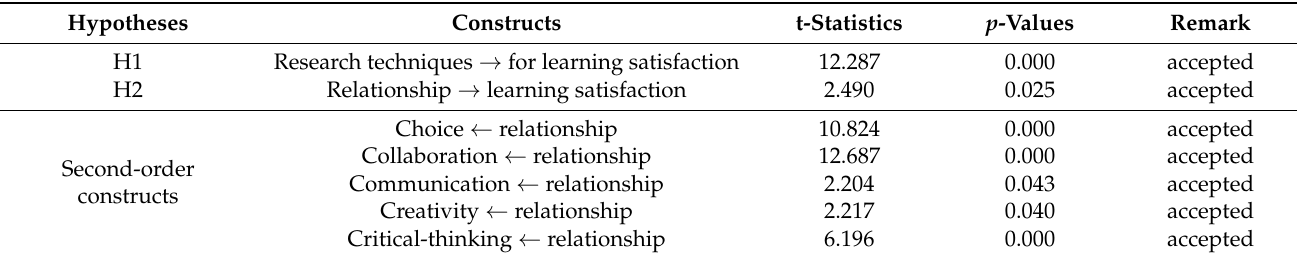
Table 5. Path Coefficients.